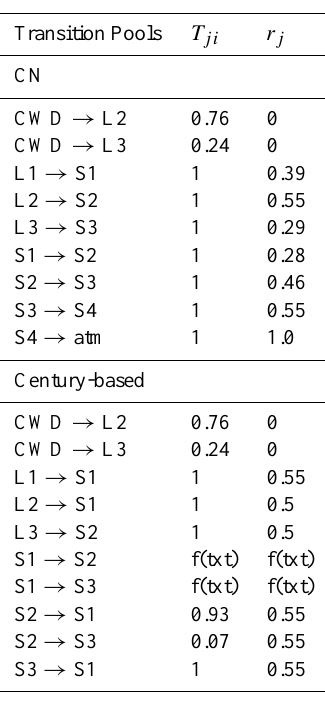
Table 2. Decomposition cascades for the two structures used in this